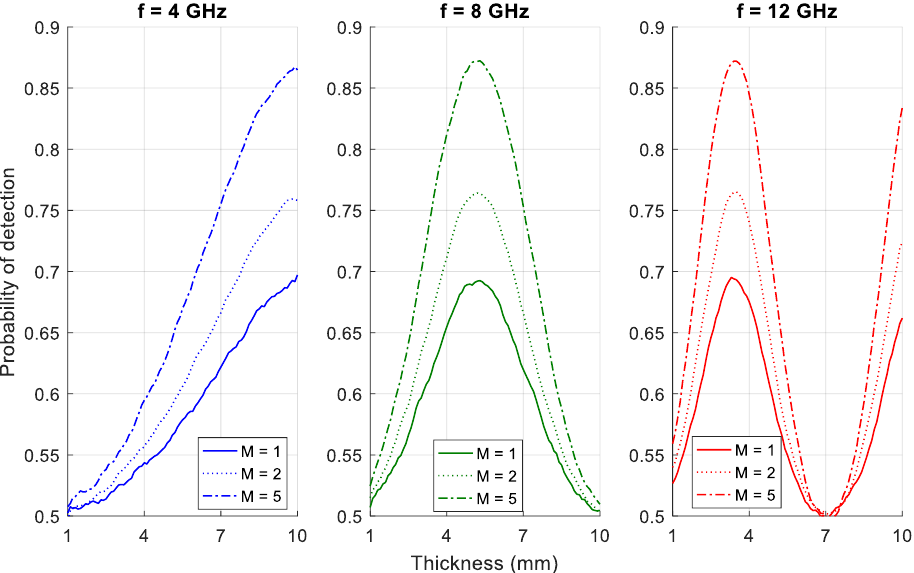
Figure 5. Comparison between the probability of detection versus the oil thickness (in mm) for single-frequency detectors at 4 GHz, 8 GHz and 12 GHz, using single observation ( M = 1) and multiple observations ( M = 2 and M = 5), with electromagnetic roughness ks =